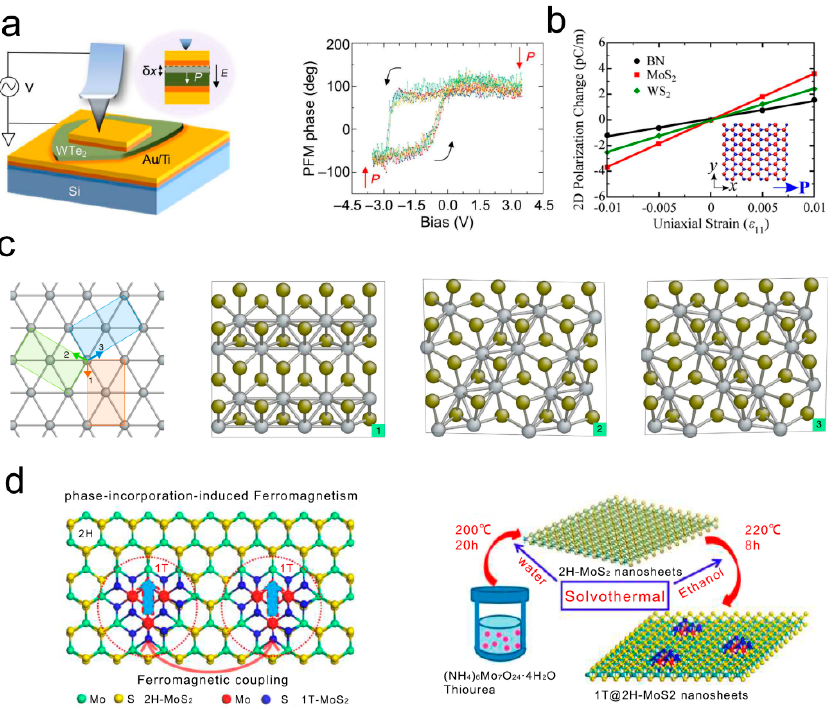
Figure 5. Ferromagnetism, ferroelasticity, and ferroelectricity of TMDs phase structure and their applications. ( a ) 1T’-WTe 2 displays ferroelectricity at room temperature. Reproduced from [74], with the permission of the AAAS. ( b ) Polarization of 2D BN, MoS 2, and WS 2 along the x -direction varies linearly with strain. TMDs have stronger piezoelectricity than BN. Reproduced from [72], with the permission of the American Chemical Society. ( c ) Tuning strain enables switching between different ferroelastic domains. Reproduced from [71], with the permission of the AAAS. ( d ) Structure and hydrothermal synthesis of 1T-MoS 2 doped with 2H-MoS 2 . Reproduced from [80], with the permission of the American Chemical